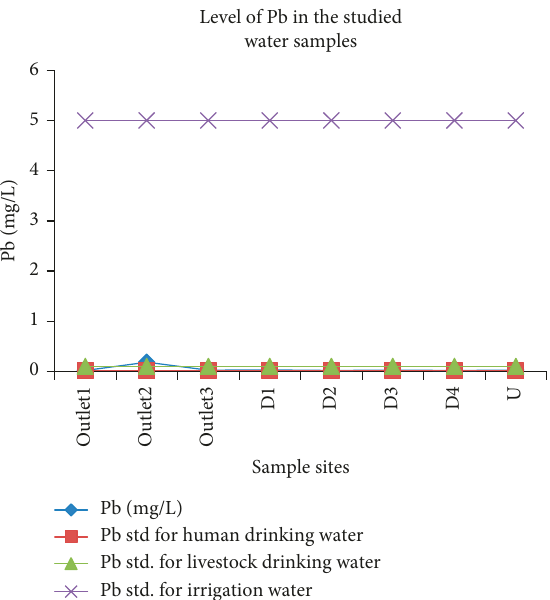
Figure 13: Comparison of the lead concentration in wastewater discharged from the Zenzelma campus and the recommended limits of lead.